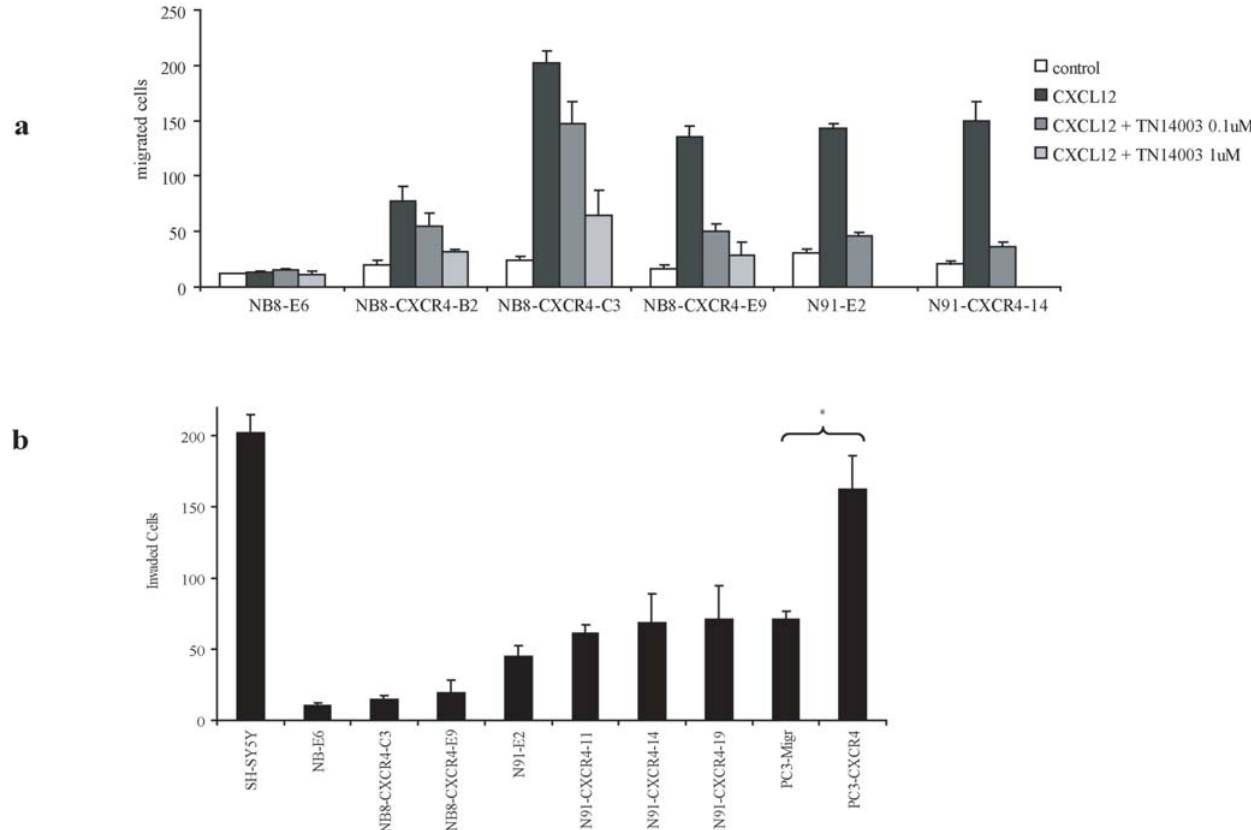
Figure 4. NB8 cell migration and invasioninvitro. (a) Migration of NB8-E6, N91-E2, and CXCR4-overexpressing clones (NB8-CXCR4-C3, -B2, -E9, N91- CXCR4-14) towards CXCL12, in absence or presence of the CXCR4 blocker (TN14003 inhibitor). Results of a representative experiment are shown and are expressed as mean number of cells in one field. Five fields were counted for each result. The experiment was performed in triplicates and repeated three times. Error bars indicate S.D. (b) Invasion of SH-SY5Y, NB8 and N91 control and CXCR4 transduced clones through Matrigel H -coated membranes in N2 supplemented serum-free medium alone, with or without CXCL12. CXCL12-mediated invading cells (invaded cell in the absence of CXCL12 have been subtracted) -in a typical field are shown. The mean number of invading cells in 5 fields is given. Error bars indicate S.D. (* indicates p , 0.05, Student’s t-test)